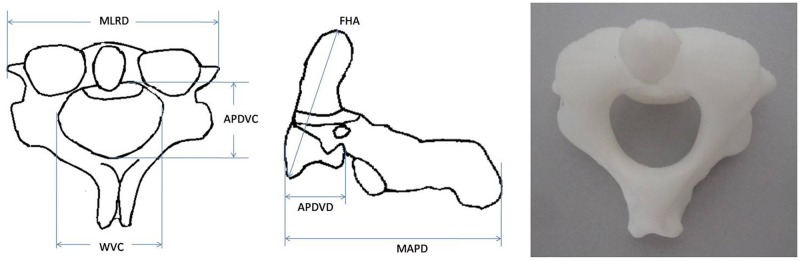
Schematic diagram showing the method of measurement for C2 (Axis).
MAPD is the abbreviation of Max anteroposterior diameter; MLRD is Max left-right diameter; APDVD is Anteroposterior diameter of vertebral body; WVC is Width of vertebral canal; APDVC is Anteroposterior diameter of vertebral canal; and FHA is Frontal height of axis (including the odontoid process).